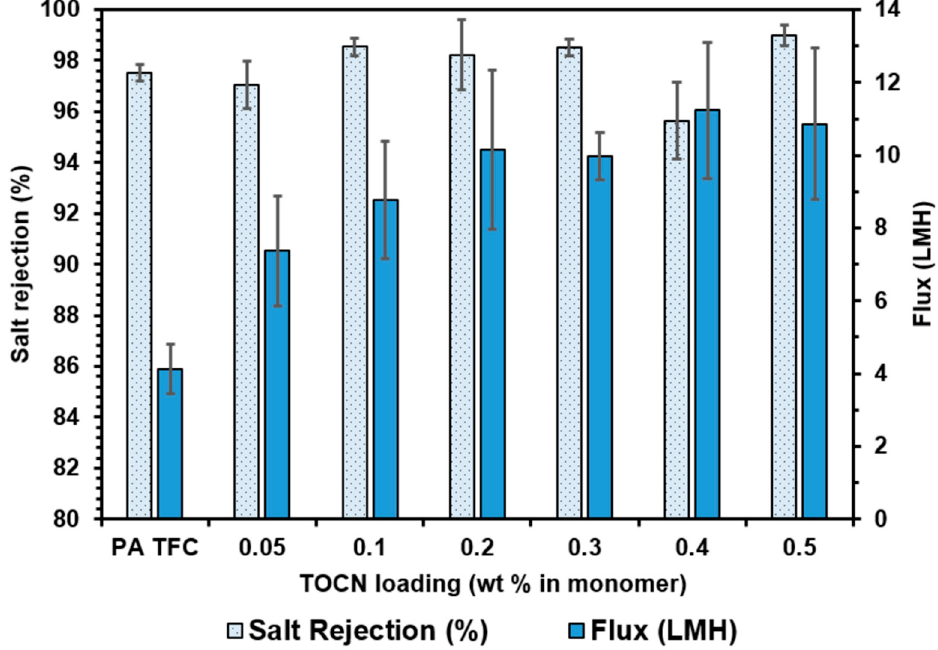
Figure 13. Flux and salt rejection results for TOCN containing TFN membranes fabricated using the monomer dispersion method.